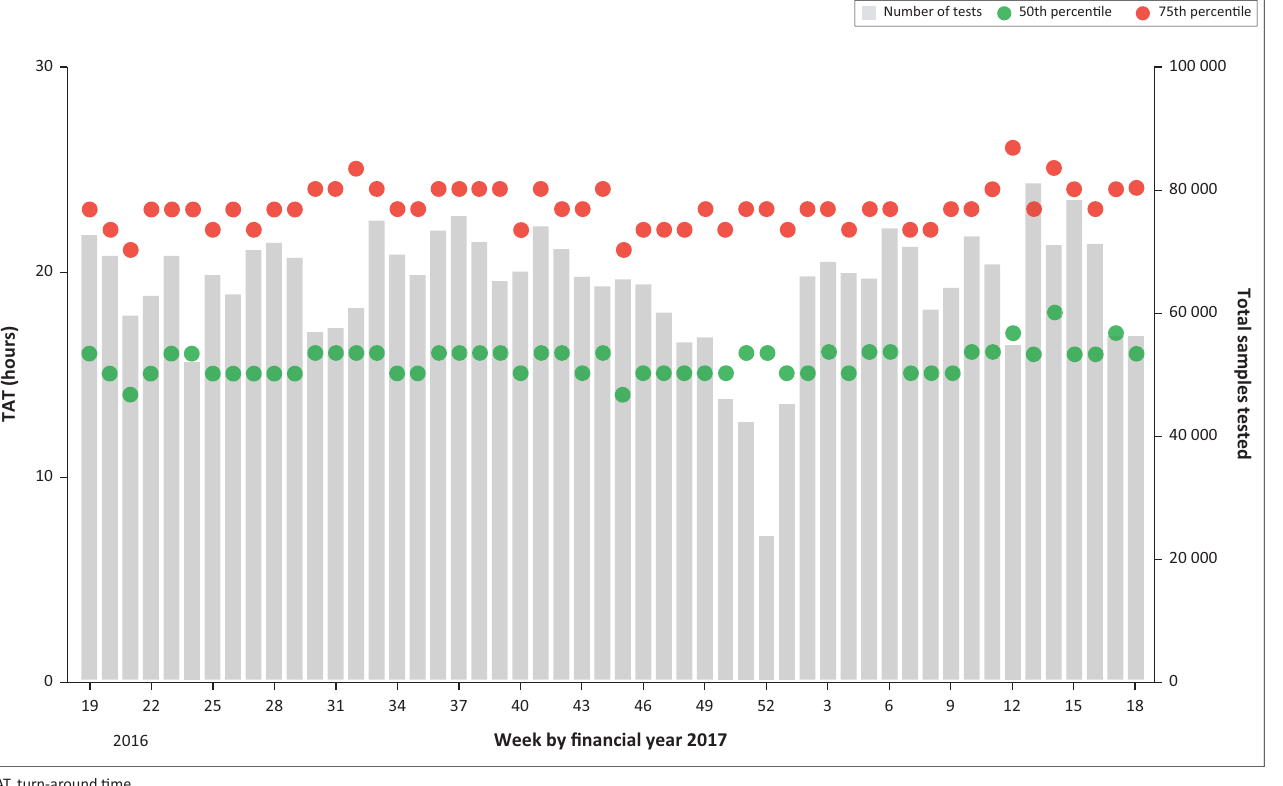
FIGURE 1: National total turn-around time of National Health Laboratory Service CD4 tests per week for the 2016/2017 financial year. The 50th percentile (median, green circles), 75th percentile (red circles) and volume of samples (grey bars) are